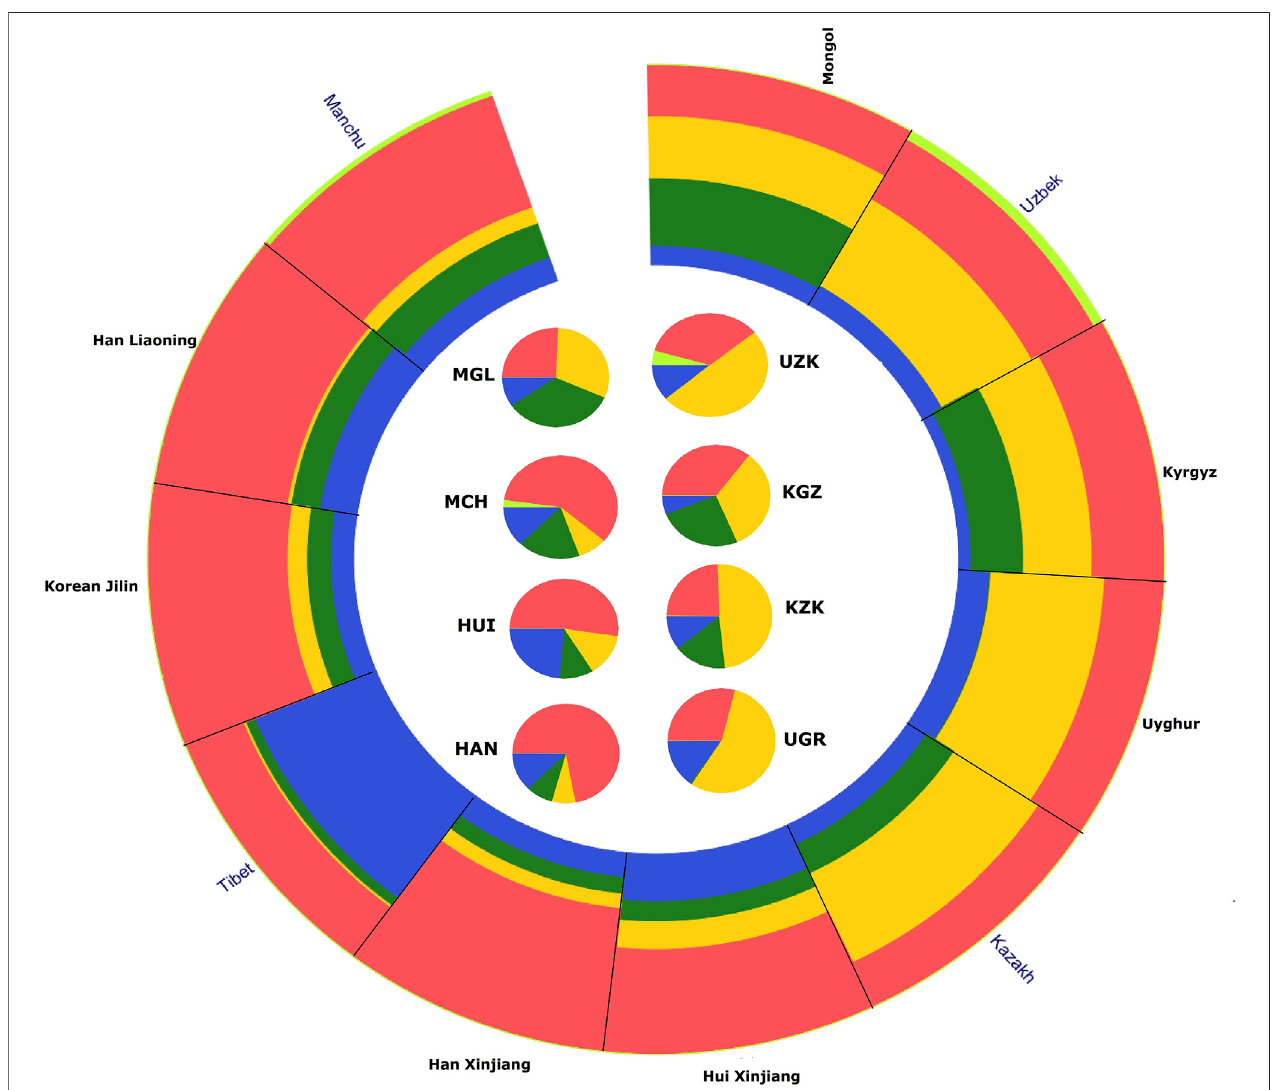
FIGURE 1 | Genetic structure and population relationship between Xinjiang Han, Uyghur, Kazakh, Hui, Manchu, Kyrgyz, Uzbek, Mongol, and other Chinese populations.